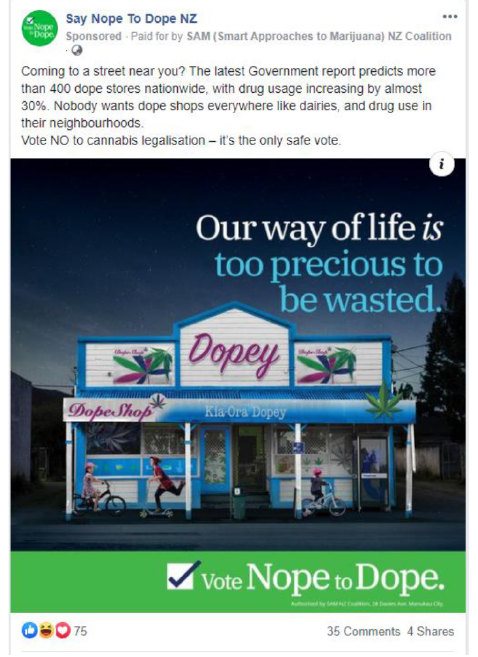
Figure 2. Example of a news article originally published on the digital channel of a TV broadcaster, shared and promoted via paid advertising by a registered referen‐ dum campaigner.